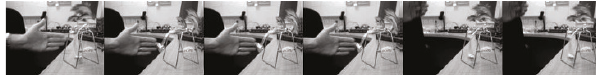
Figure 17: Frames from the temporally decimated